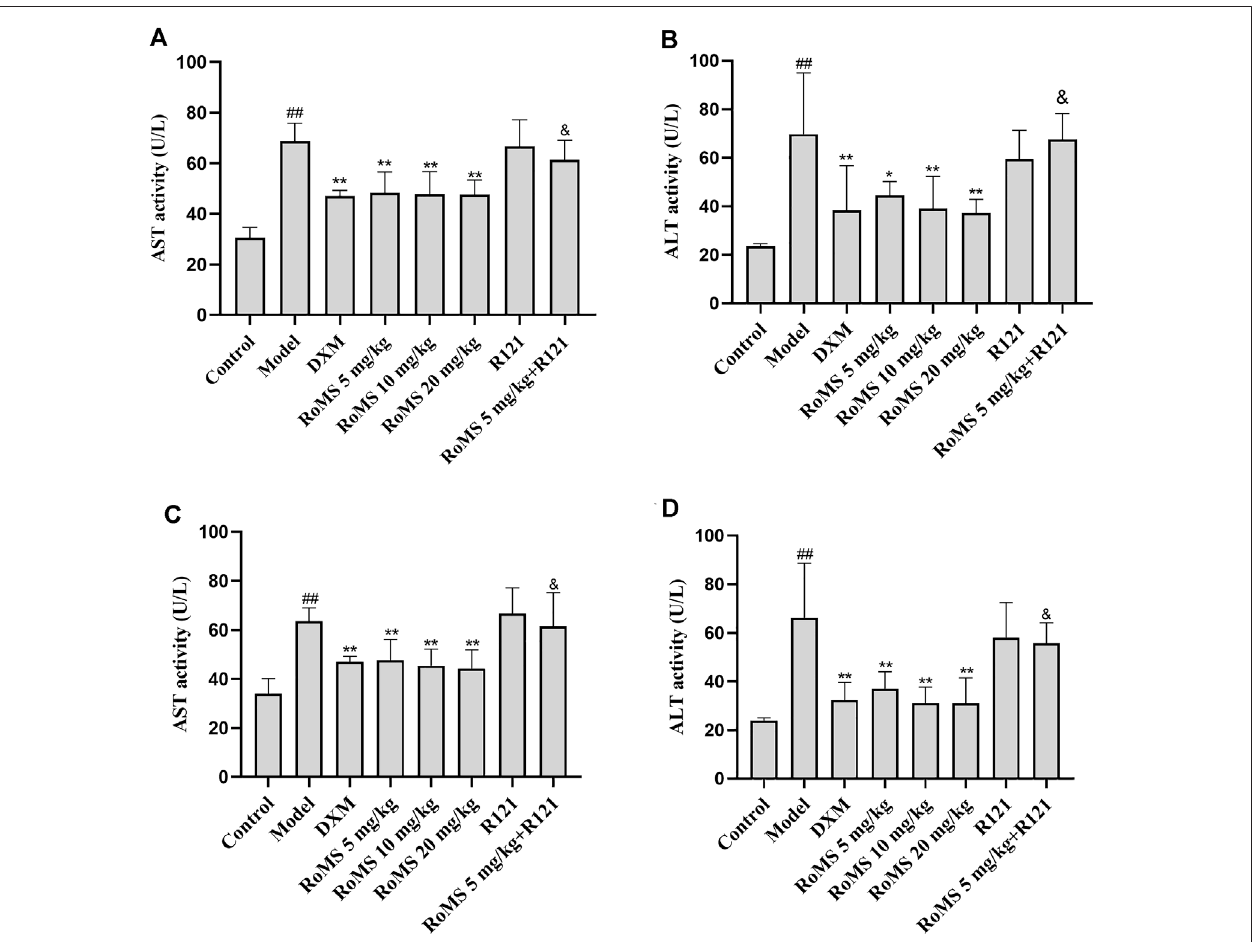
FIGURE2| EffectsofRoMSonserumaminotransferasesactivities.At3daysafterRoMSpre-administration (A,B) .At7daysafterRoMSpre-administration (C,D) . The data are expressed as the mean ± SD (n = 8 in each group). ## p < 0.01 versus the control group, * p < 0.05 or ** p < 0.01 versus the model group, & p < 0.05 or && p < 0.01 versus RoMS 5 mg/kg